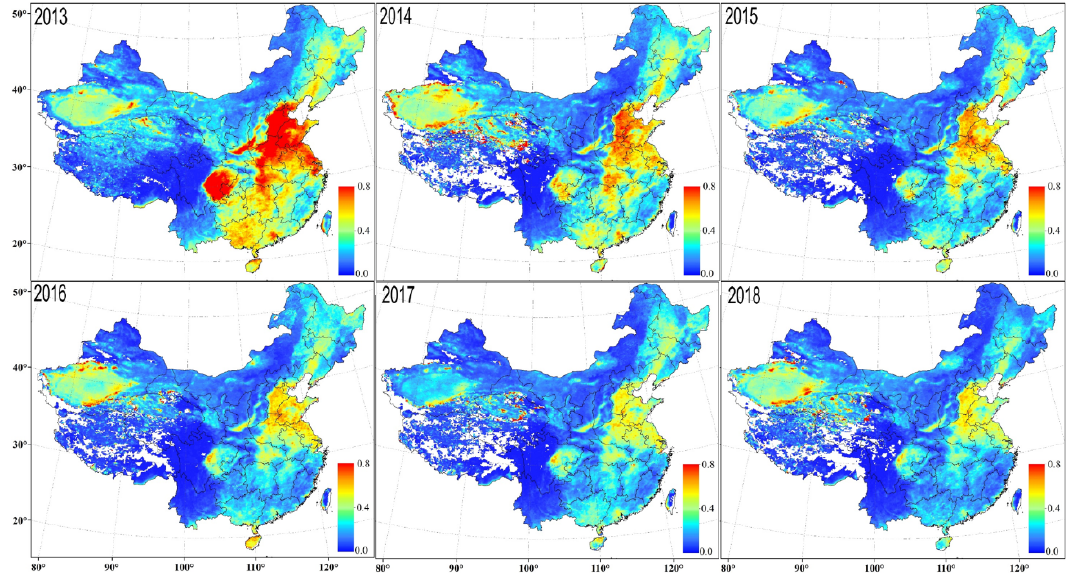
Figure 3. Annual mean of MODIS DB AOD over China during 2013–2018.